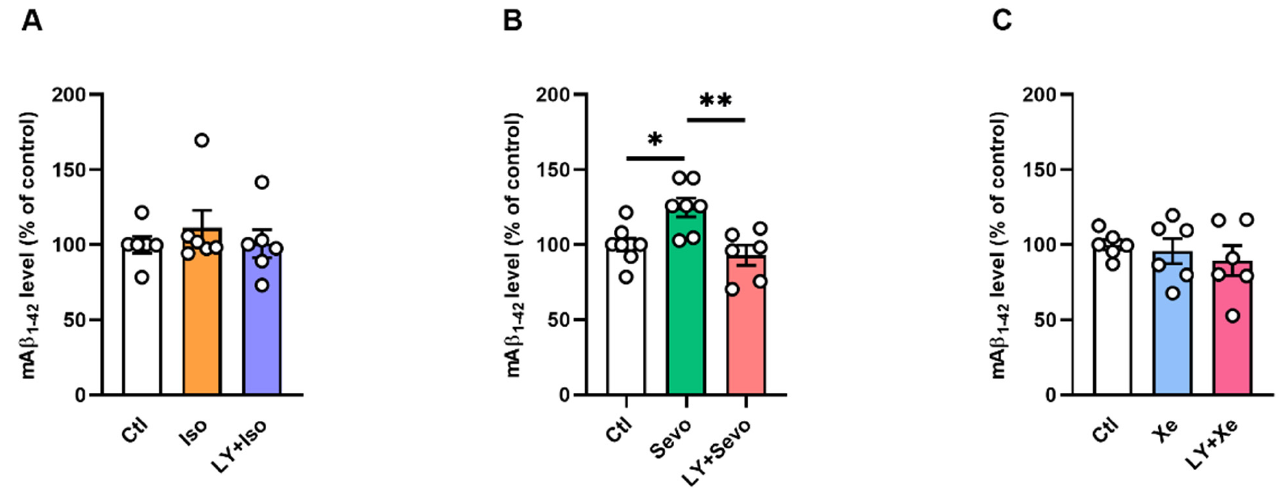
Figure 1. Increased mA β 1–42 levels by sevo were restored by BACE inhibition. ( A , C ) Mouse A β 1–42 levels were comparable between groups. ( B ) Sevo increased mA β 1–42 levels dramatically (ctl vs. sevo: p = 0.0134), and pretreatment of LY reversed that effect (sevo vs. LY + sevo: p = 0.0034). One-way ANOVA followed by Tukey’s test. Data are shown as mean ± SEM. Dots represent the number of animals. Detailed statistics are provided in Table S1. * p < 0.05, ** p < 0.01. A β : amyloid beta, ctl: